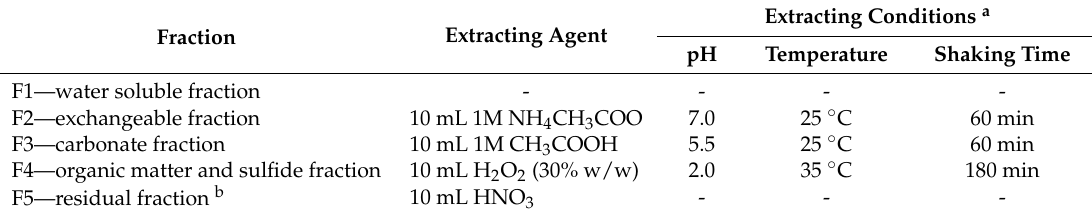
Table 2. Extracting agents and conditions applied in the sequential extraction protocol to determine the highly bioavailable (F1 and F2) fractions of Fe and Co supplemented to the rice straw used in this study for AD. Fraction Extracting Agent